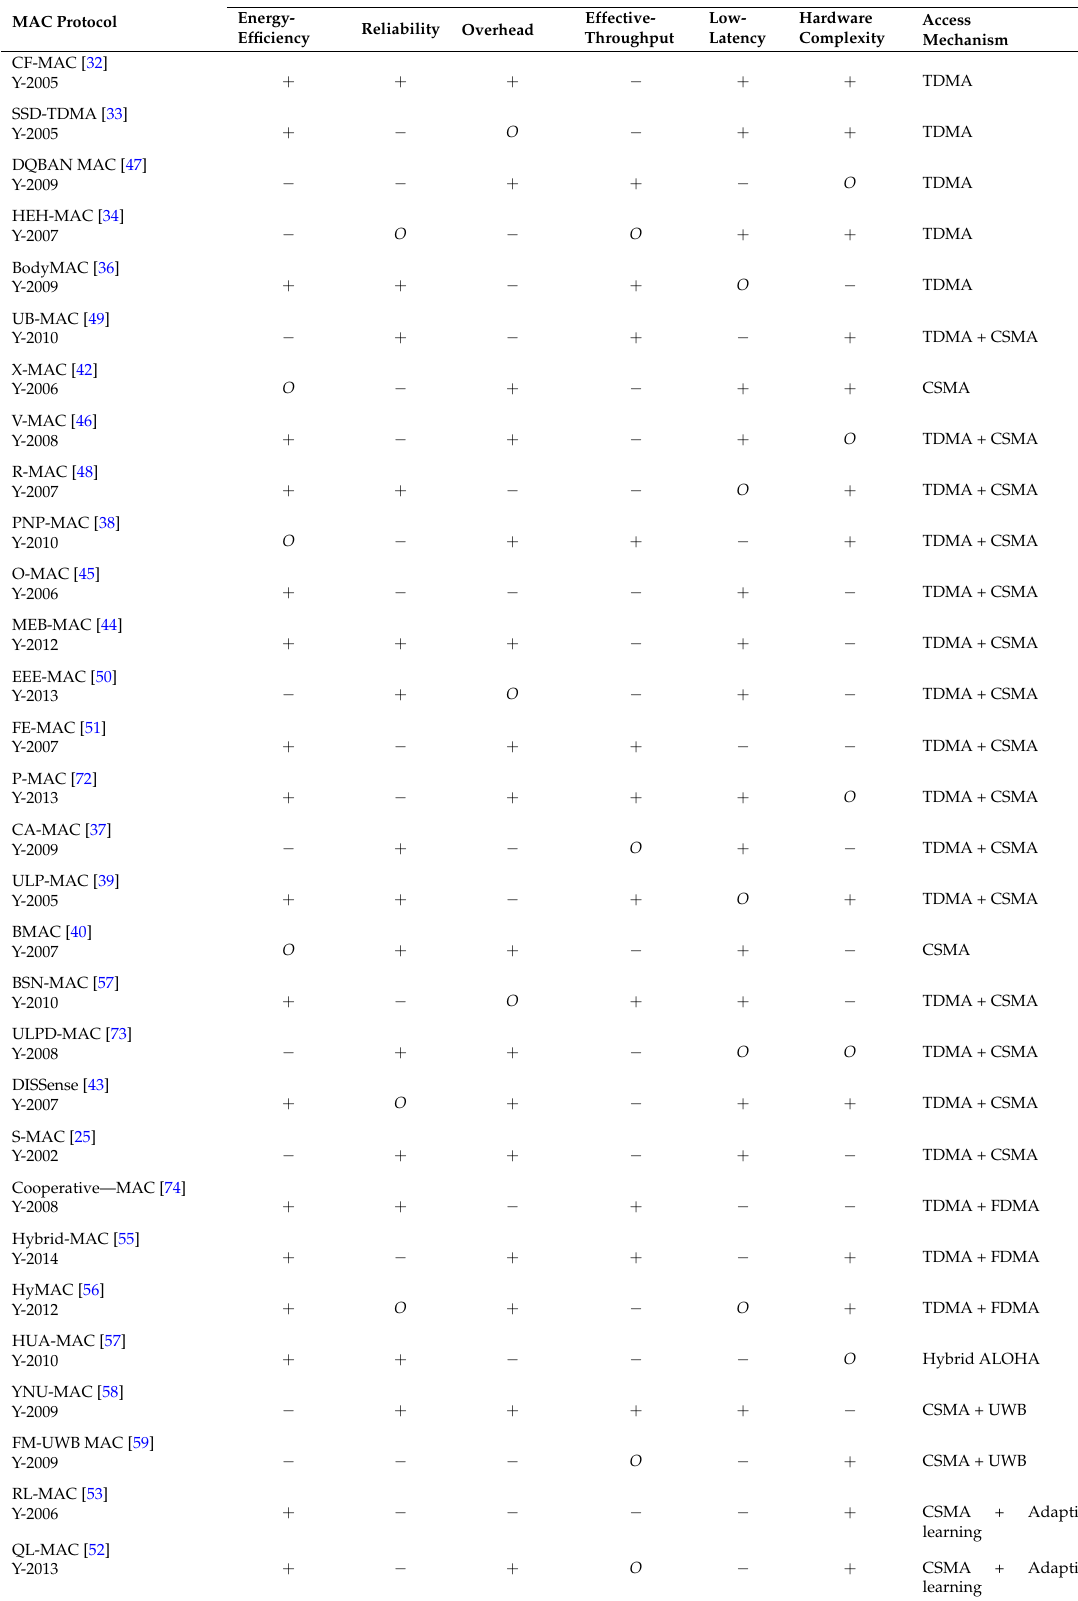
Table 11. Comparision of MAC protocols. Legends: ’ + ’ = Positive; ’ ’ O ’ =